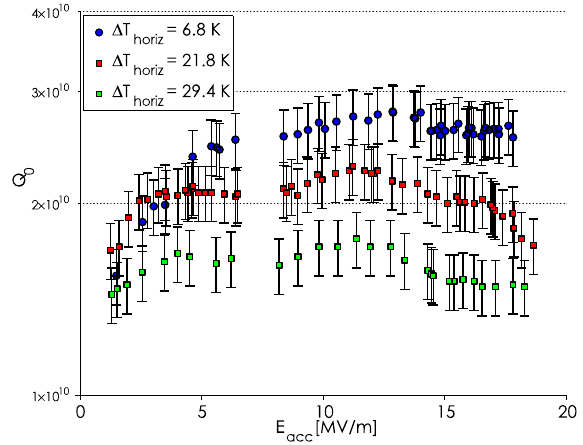
FIG. 9. Q 0 vs E performance of an LCLS-II N-doped 9-cell acc cavity at 2.0 K in the Cornell Horizontal-Test Cryomodule for different temperature gradients between the cavity ends near T c . Uncertainty on E is 10%. acc